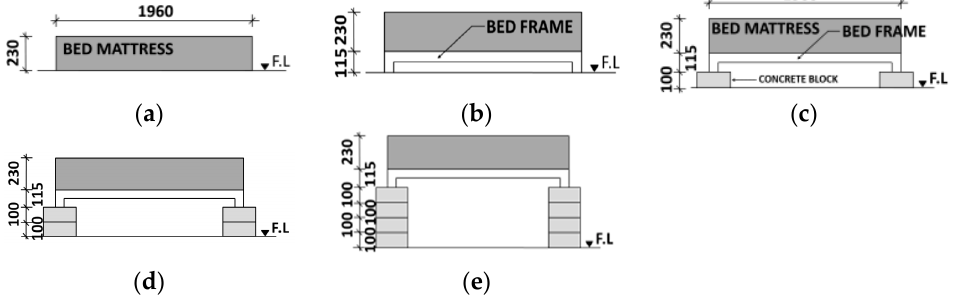
Figure 4. Bed-mattress placement on the floor. ( a ) HB 0 mm. ( b ) HB 115 mm. ( c ) HB 215 mm. ( d ) HB 315 mm. ( e ) HB 515 mm